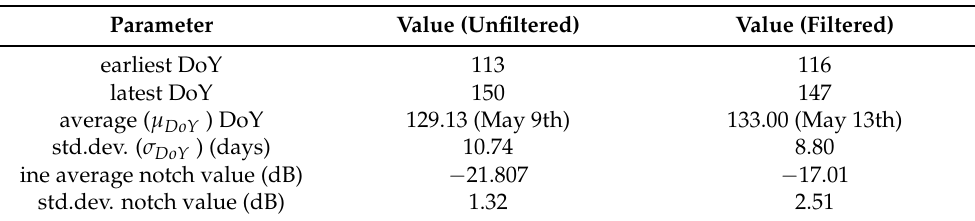
Figure 6. Plot of frequency spectrum magnitude for the reference rice field. Please note that the horizontal axis is normalized to the Nyquist frequency f Nyquist = 1. Table 1. Statistical features of minima in training-set SAR series, before (center column) and after (right column) low-pass